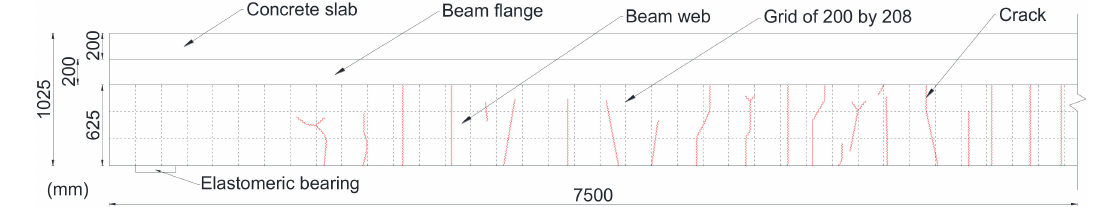
Figure 3. Crack distribution on the T-beam (half beam) prior to the retrofitting work on